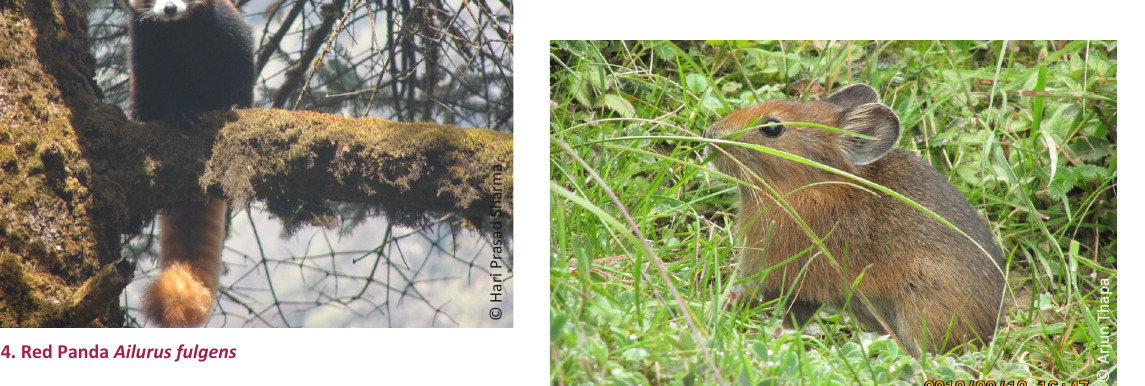
Image 5. Masked Palm Civet Paguma larvata